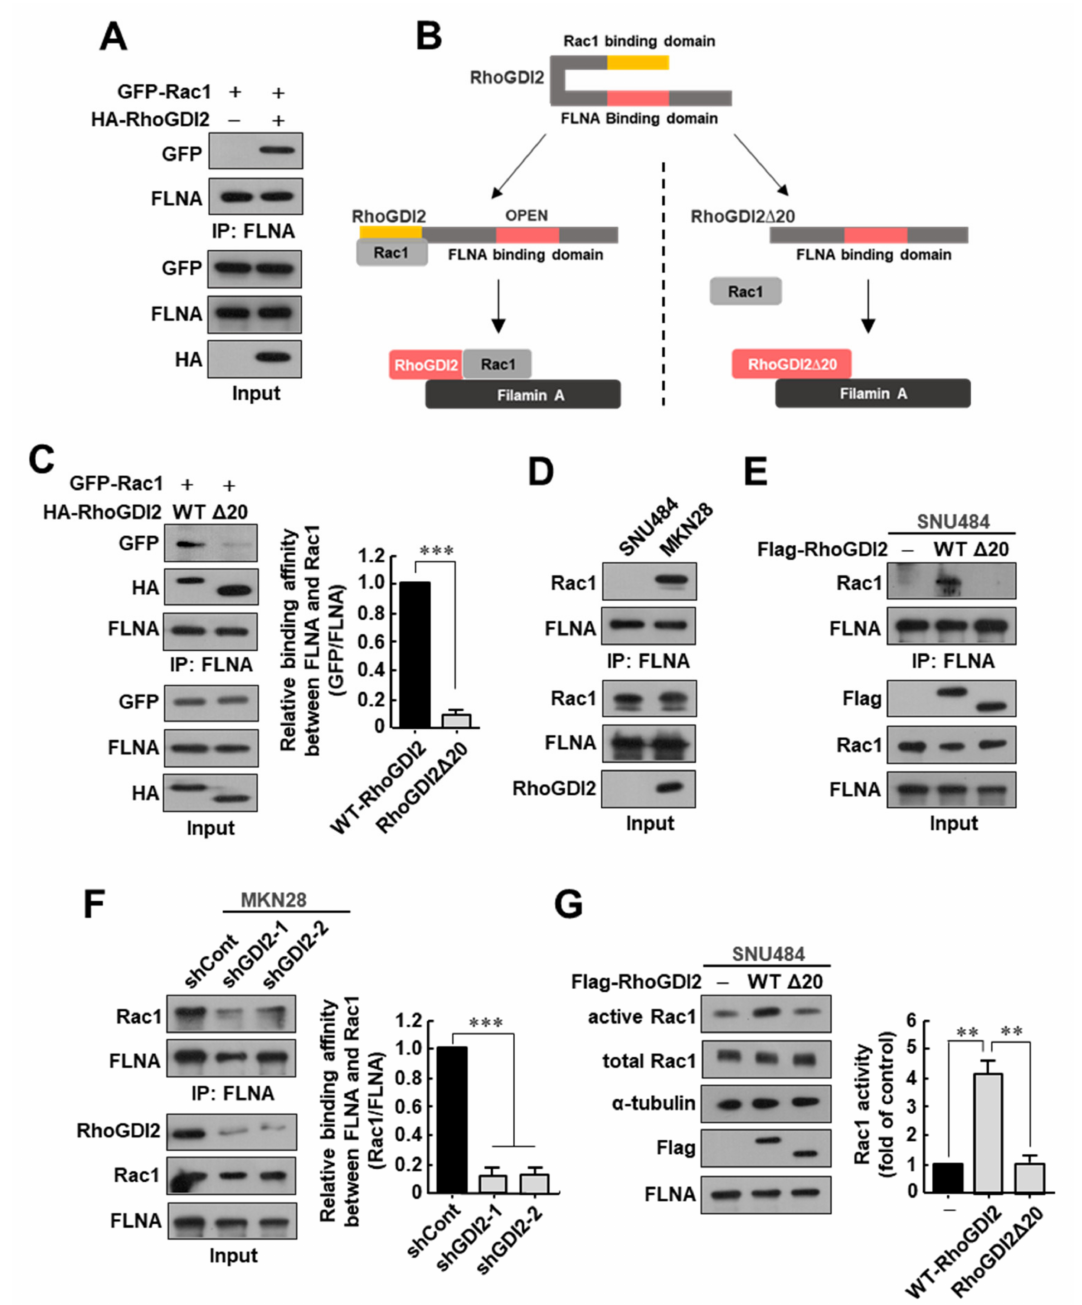
Figure 2. RhoGDI2 plays an important role in the interaction between Rac1 and Filamin A and Rac1 activation in gastric cancer cells. ( A ) Interaction between endogenous Filamin A with exogenous Rac1 in the presence or absence of RhoGDI2. HEK293T cells transfected with indicated constructs were immunoprecipitated and analyzed by Western blot. The uncropped immunoblot images can be found in Figure S3. ( B ) Schematic diagram of the conformational changes in wild type RhoGDI2 or RhoGDI2 ∆ 20 after binding to Rac1. ( C ) Interaction between endogenous Filamin A with exogenous Rac1 in the presence of wild type RhoGDI2 or RhoGDI2 ∆ 20. HEK293T cells transfected with